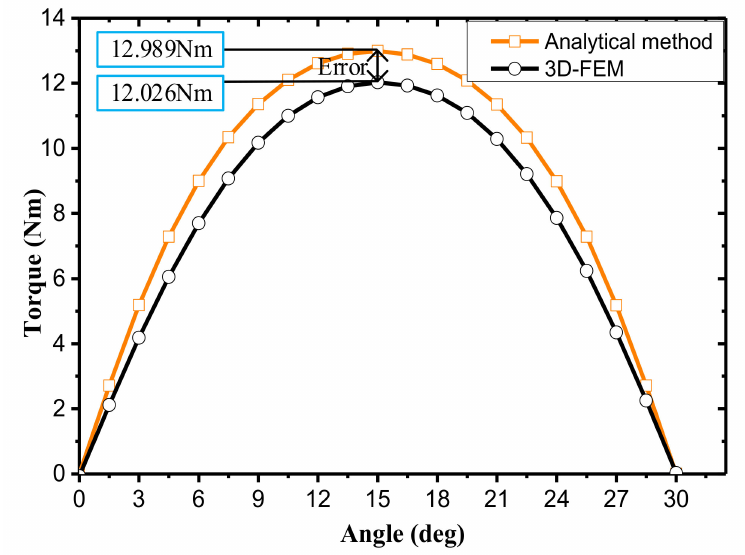
Figure 10. Comparison of 3D-FEM and analytical